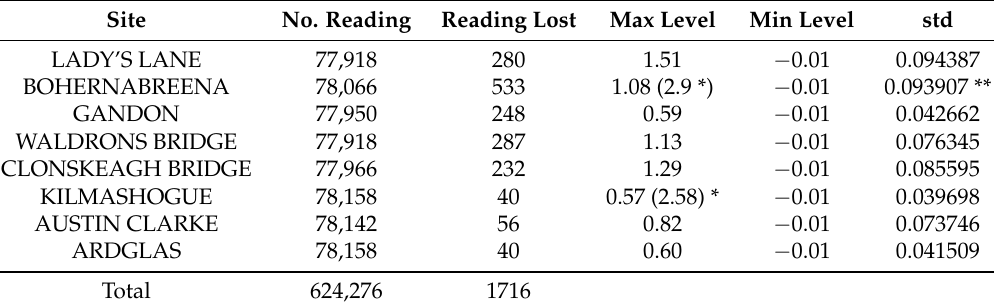
Table 2. Data received from all sensor units and the maximum, minimum and the standard deviation of the measurements. *max level reading that might be noise. ** Standard divination (std) is